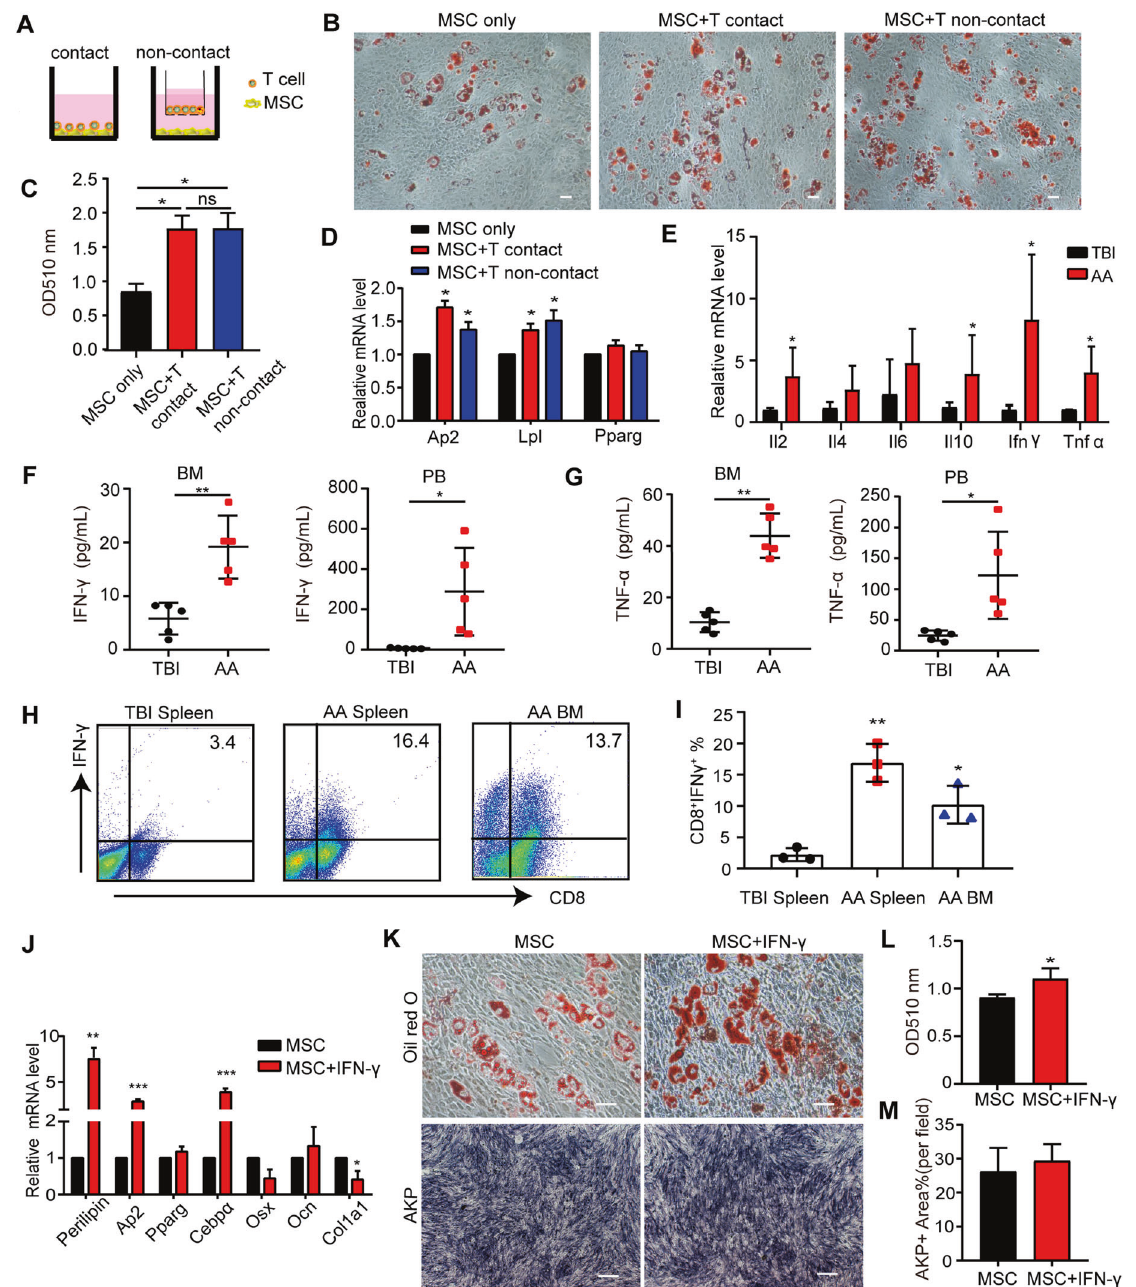
Fig. 3 BM-MSCs were differentiated into adipogenic lineage by ConA-activated T cells and IFN- γ . A Outline of coculture system relating to direct contact model of BM-MSCs with CD3 + T cells (left), or non-contact model (right) in 0.4 μ m pore size of transwell system, where murine CD3 + T cells were plated in the upper chamber and BM-MSCs were in the lower chamber. Oil Red O staining ( B ) and quantitative OD value at 510 nm ( C , mean±SEM) in the presence or absence of CD3 + T cells after 14 days of adipogenic differentiation of murine BM-MSCs. Scale bar:50 μ m. * P < 0.05. D Expression of adipogenic markers ( Ap2, Lpl, and Pparg ) of murine BM-MSCs in the models of direct-contact or non- contact were analyzed 14 days after adipogenic induction. Data represented mean ± SEM in three independent experiments. * P < 0.05. E Expression of IL-2, IL-4, IL-6, IL-10, IFN- γ , and TNF- α in BM cells of TBI and AA mice were determined by qRT-PCR. Data represent mean ± SEM in three independent experiments. * P < 0.05. The concentrations of IFN- γ ( F ) and TNF- α ( G ) in the supernatant of 500 μ L/femur BM fl ushing fl uid and in the serum of TBI mice and AA mice on day 14 were assessed by CBA kit. Data were presented as the mean ± SD. N = 5 in each group. * P < 0.05, ** P < 0.01. FACs analyses of representative dot plot ( H ) and mean±SD ( I ) of intracellular staining of IFN- γ in murine CD8 + T cells from TBI spleen, AA spleen, and AA BM. Data were representative of three independent experiments. J Expression of adipocytic markers ( Perilipin, Lpl , Cebp α , Pparg ) and osteoblastic markers ( Osx , Ocn , and Col1a1 ) in the presence or absence of IFN- γ of murine BM-MSCs was assessed by qRT-PCR after adipogenic/osteogenic induction. Data represent mean±SEM in three independent experiments. * P < 0.05, ** P < 0.01, *** P < 0.001. K – M BM-MSCs were incubated with IFN- γ (10 ng/mL) for 72 h, and then cultured in differentiation media. K Staining of Oil Red O or AKP was performed on BM-MSCs 14 days after adipogenic or osteogenic differentiation respectively, in the presence or absence of IFN- γ . Scale bar: 50 μ m. OD value at 510 nm of Oil Red O staining ( L ) and area of AKP-positive staining ( M ) were determined. Data represent mean±SEM in three independent experiments. * P <